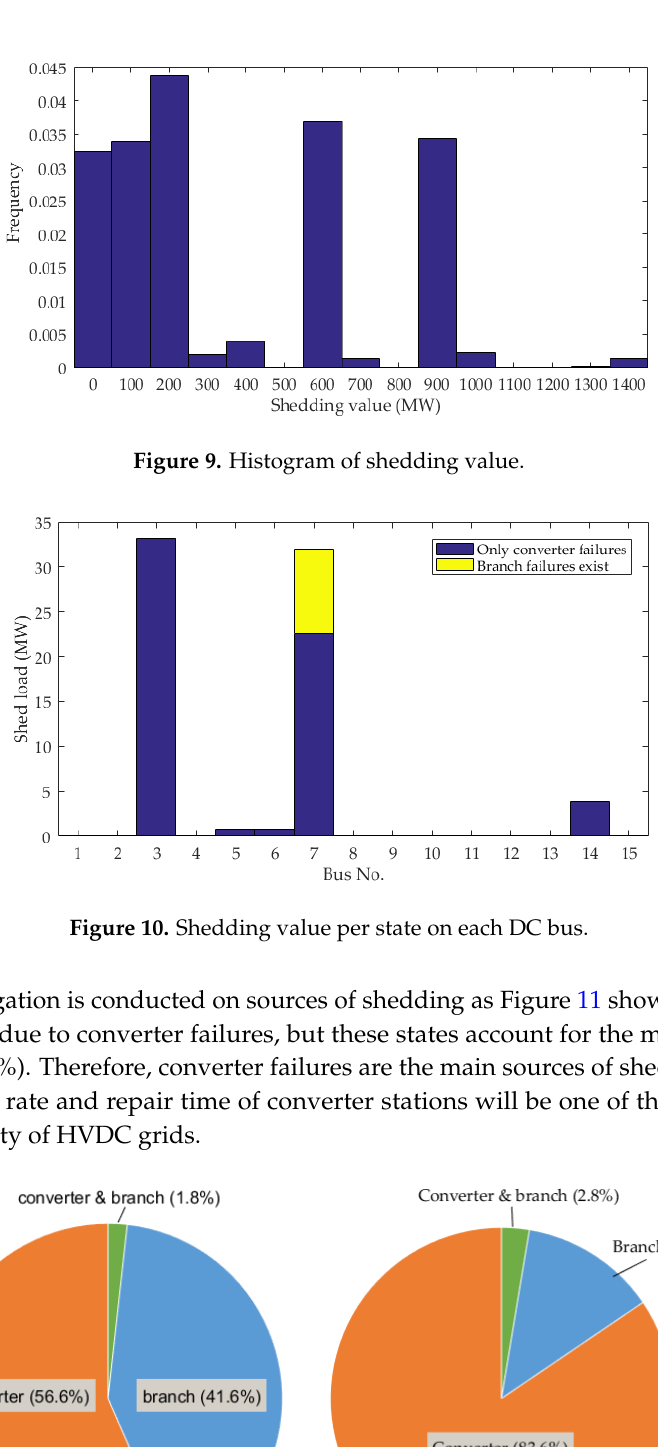
Figure 11. Proportions of shedding sources (CIGRE B4 DC grid). ( a ) Number of shedding occurrences; and ( b ) shed power.